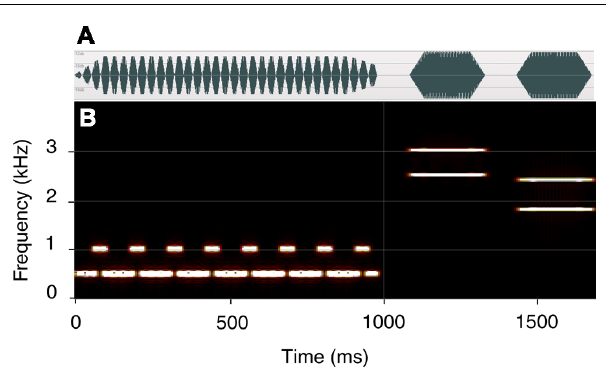
FIGURE 2 | Experimental trial. The prime is presented at the rate of 33 pps and the ISI is 100 ms. A spectral down – virtual up (SDVU) target is shown. (A) the waveform; (B) time-frequency plot.The first target tone carries the fifth and sixth harmonic of 500 Hz (2500 + 3000 Hz) and is harmonically related to the prime.The second target tone carries the third and fourth harmonics of 600 Hz (1800 + 2400 Hz). A reversed target (SUVD) was presented on 50% of the